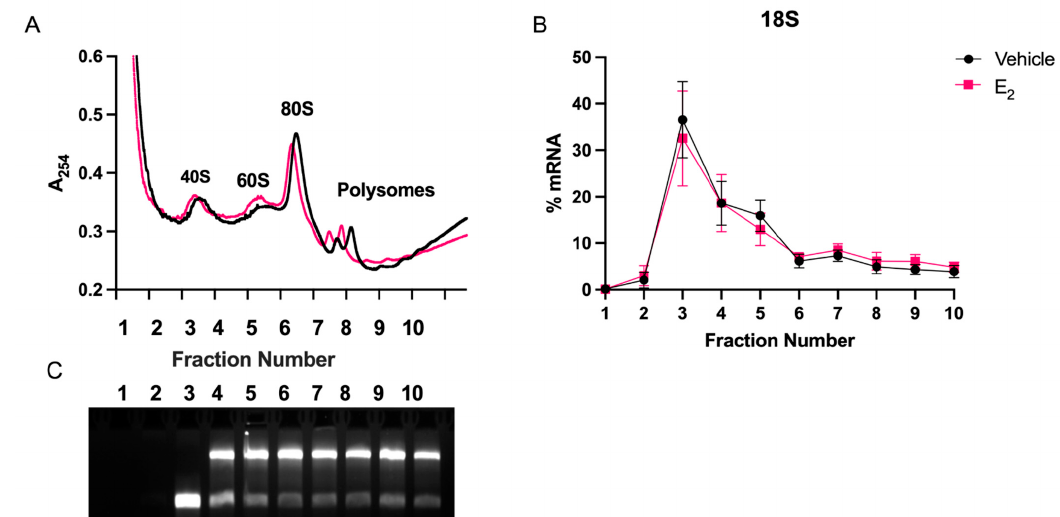
Figure 5. Polysome profiles were not altered following E 2 treatment in hypothalamic-derived neuronal cells. Cells were treated with E 2 for 15 h and fractionated using sucrose gradient density sedimentation. ( A ) A254 measurements representing ribosomal or polyribosome subunits and the corresponding fraction numbers for vehicle (black line) or E 2 treatment (red line). Positions of 40S, 60S and 80S ribosomal subunits and polysomes are indicated. ( B ) 18S polysome profile from cells treated with vehicle or E 2 . ( C ) Representative ethidium bromide RNA gel of 18S and 28S ribosomal subunits recovered in each RNA fraction. Non-Coding RNA 2021 , 7 , x